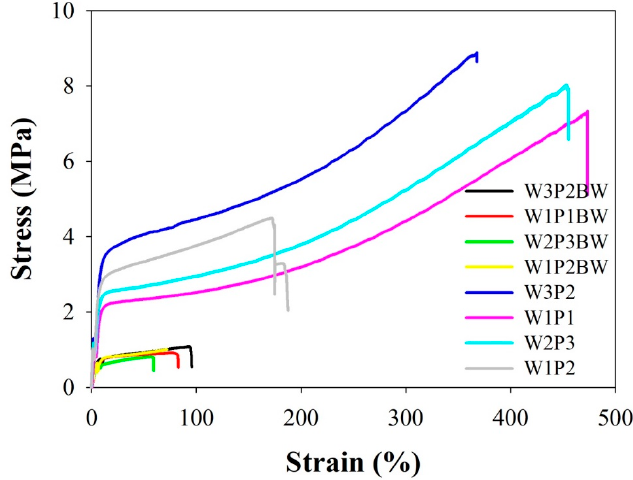
Figure 3. The stress–strain curves of NFMs with different volume WPU/PEO ratios before and after PBS treatment (BW stands for “before wash”; W3P2BW means W3P2 before washing; and W3P2 indicates the status after washing): After PEO was removed through the PBS treatment, the ultimate tensile strength, the elongation percentage at break, and Young’s modulus of all WPU NFMs were higher. Table 2. The ultimate tensile strength, elongation percentage at break, and Young’s modulus of NFMs with different volume WPU/PEO ratios before and after the PBS treatment (BW stands for “before wash”; W3P2BW means W3P2 before washing; and W3P2 indicates the status after washing). After PEO removal through the PBS treatment, the mechanical properties of all WPU NFMs were improved. Membrane